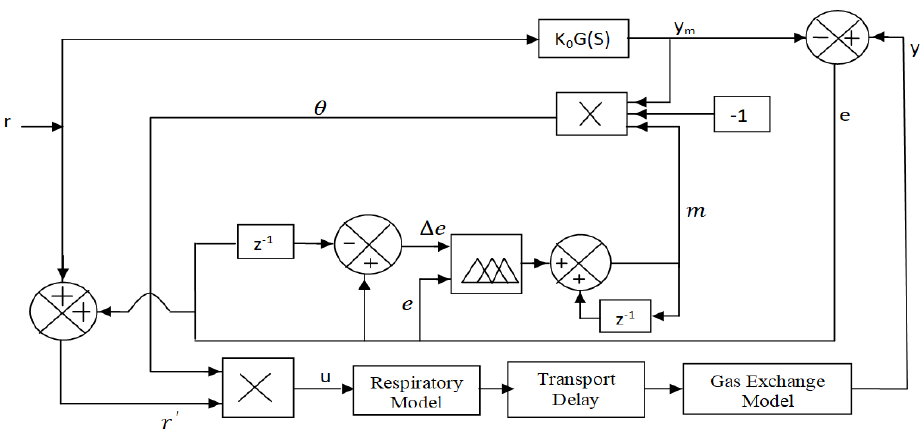
Figure 22. Simulink model of SFPIMRAC with transport delay in between respiratory model and gas exchange model. exchange model.